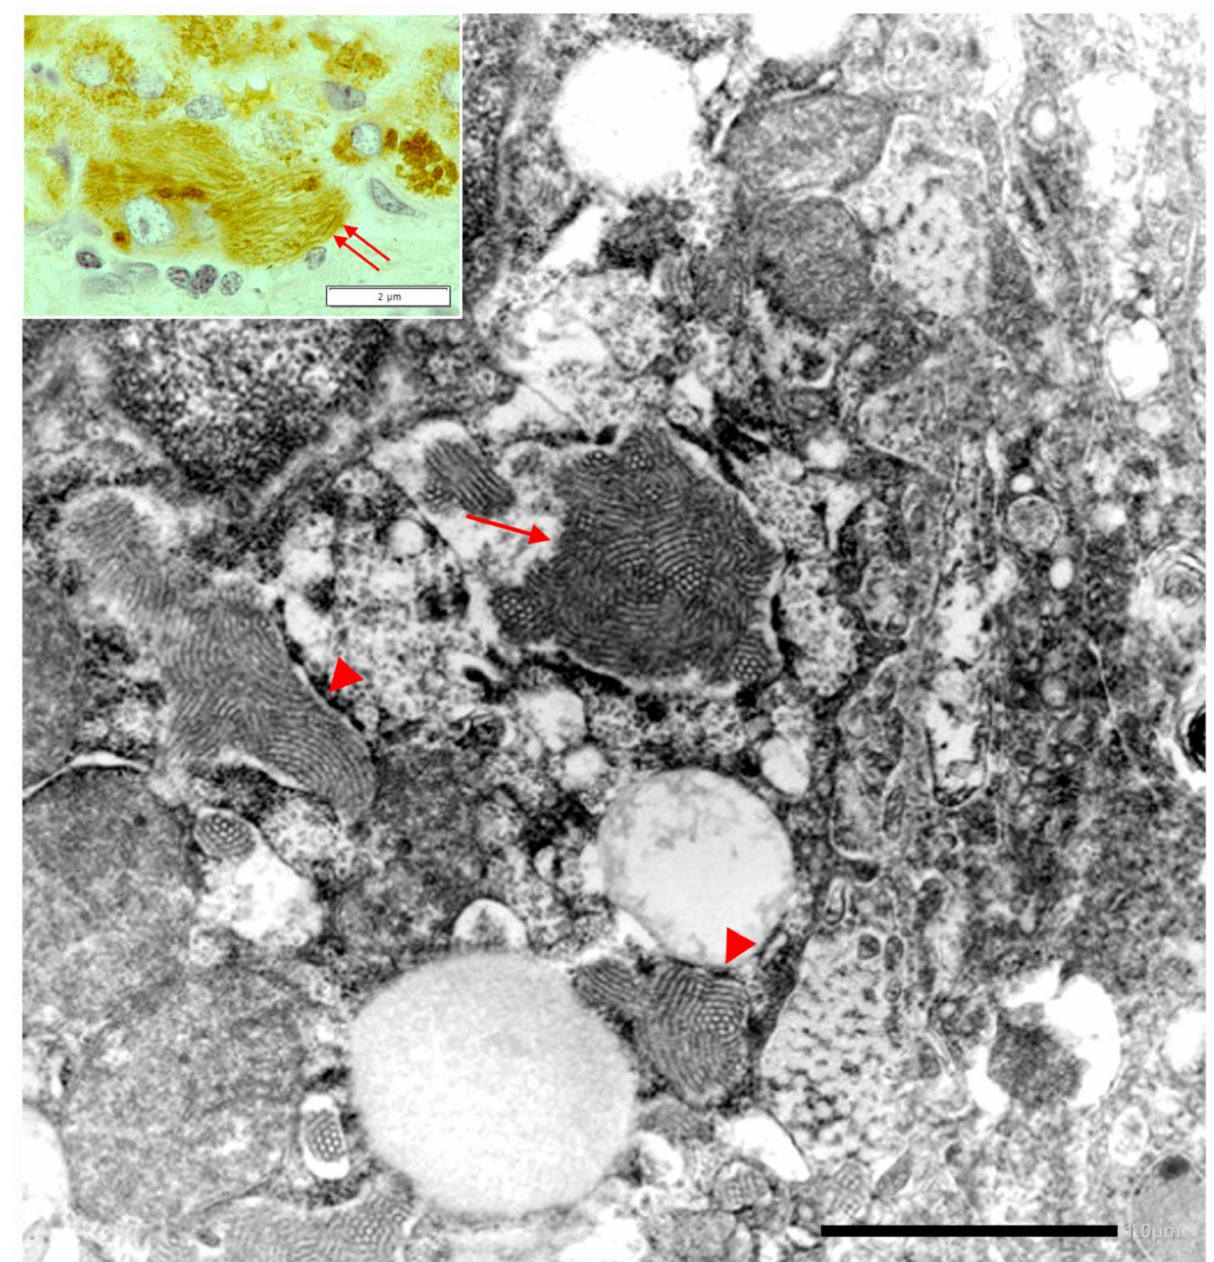
Figure 16. The electronmicrograh shows a hepatocyte with dilated RER containing densely packed tubular structures arranged in curved bundles (finger print-like) (arrow), or elongated fibers with a metameric array (arrow-heads) correspond- ing to fibrinogen, reminiscent of extracellular fibrin (EM × 8.000). The elongated fibers appear as acicular fiber glass-like inclusions (double arrow) (Inset: FGG immunostaining ×